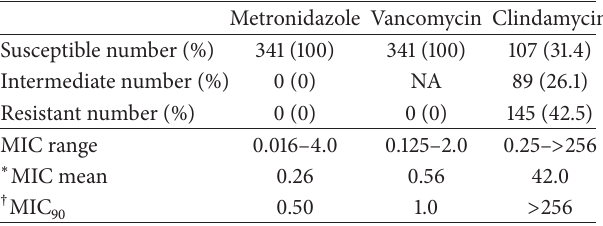
Table 2: Antimicrobial susceptibility of C. difficile present in British Columbia in 2008 ( 𝜇 g/mL).